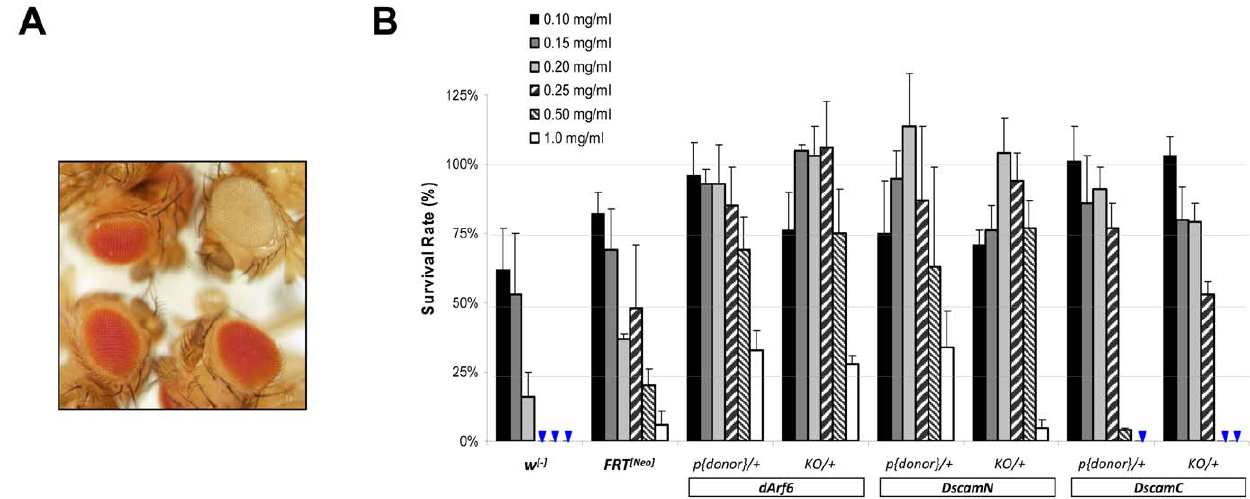
Figure 2. Expression of W::Neo confers both w + and G418-resistance in flies. A . Eye color in representative males from (clockwise from top right): w 1118 , y w; pArf6 GX22 /TM3 , y w; pDscam-N GX113 /TM3 , and y w; pDscam-C GX1 /TM3 . B . G418-resistance of W::Neo transgenic donor lines and founder knock-out flies. Arrowheads indicate 0% survival rate. FRT [Neo] : y w; FRT-42D ubi::GFP NLS / + ; P{donor} : transgenic donor insertion; KO : targeting allele; w [ 2 ] : TM3/ + and CyO/ + cross progeny. See Materials and Methods for detail genotypes.